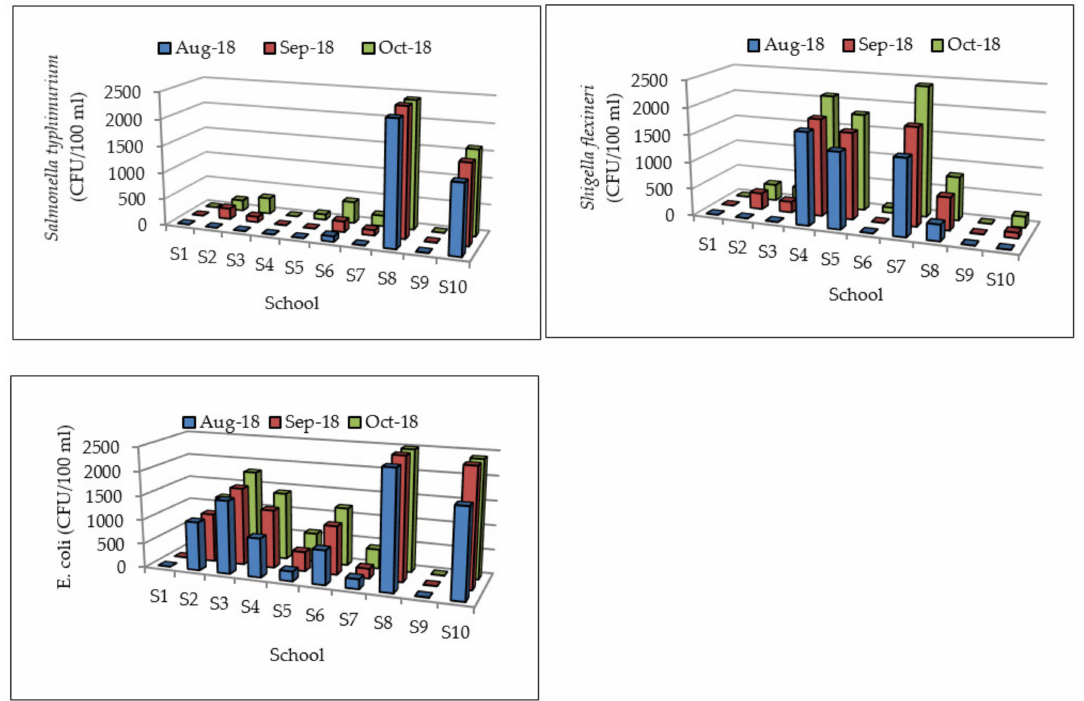
Figure 5. Salmonella typhimurium , Shigella flexneri , and E. coli in groundwater.